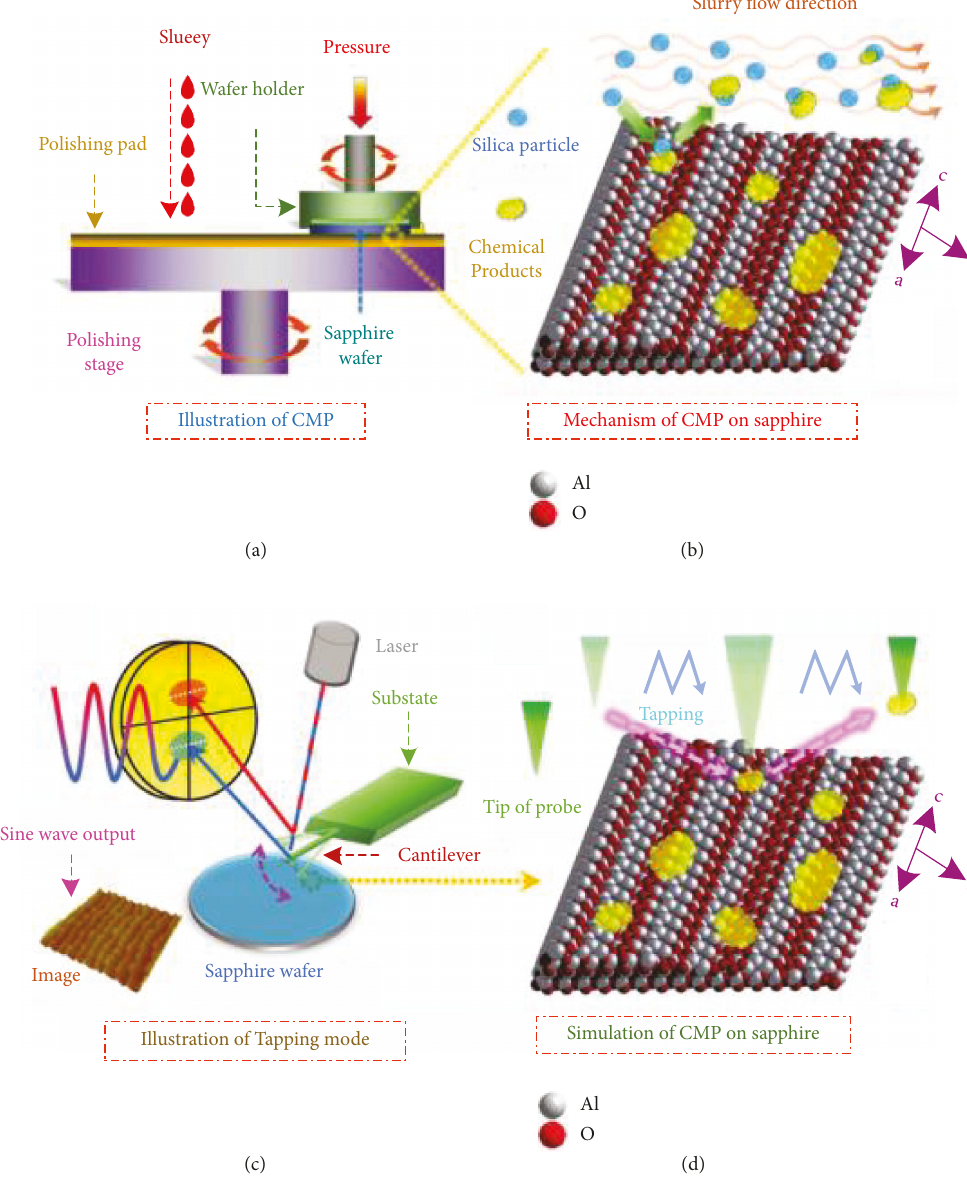
Figure 32: CMP and atomic force microscopy (AFM)-tapping mode principles diagram